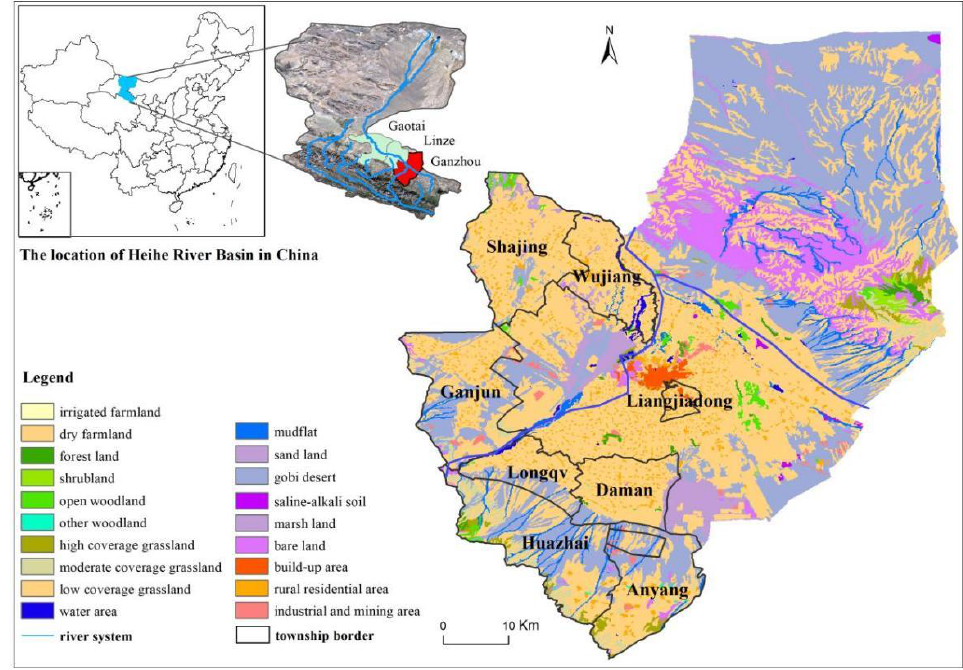
Figure 1. Overview of the study area and the locations of the eight townships.